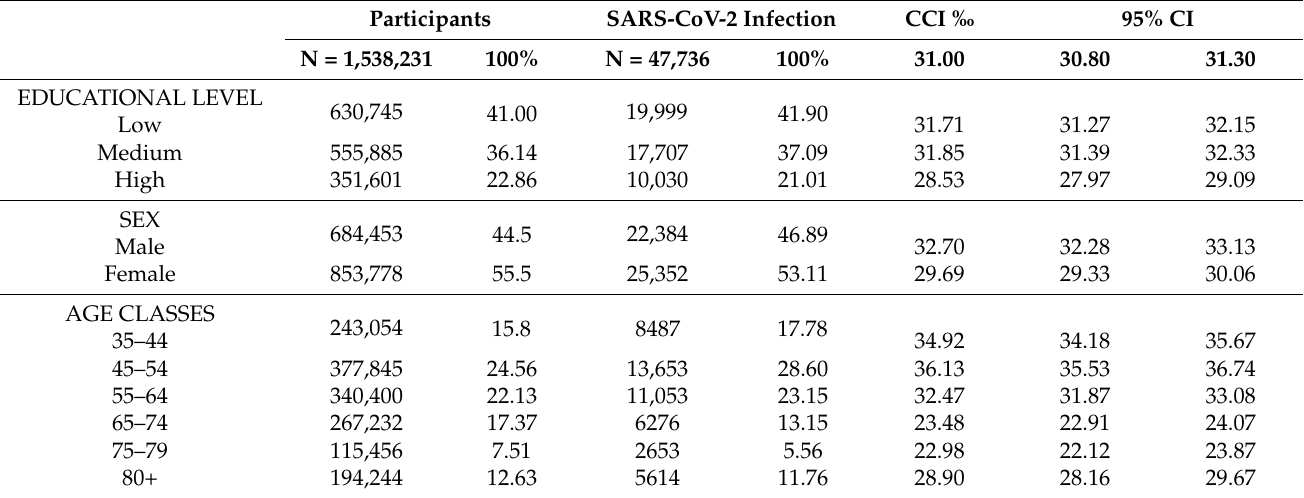
Table 1. SARS-CoV-2 infections by educational level, sex, and age. Crude cumulative incidence (CCI) with 95% CI. Rome, 35+ years old, 1 March to 31 December